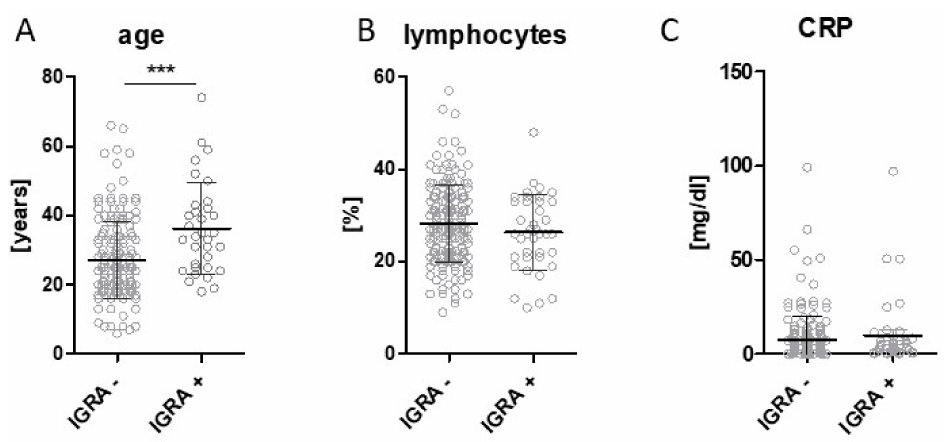
Figure 3. The analysis of subject-specific parameters in refugees with negative (IGRA − ) or positive (IGRA +) testing results. ( A ) age; ( B ) CRP; ( C ) hemoglobin (bars display the mean plus standard deviation, Hb: hemoglobin, *** P <